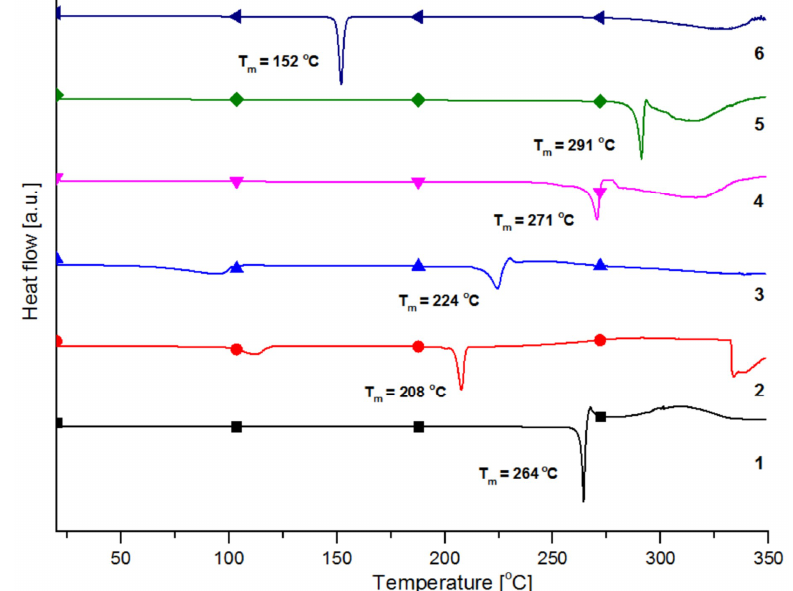
Figure 3. Combined graphical representation of the results from the DSC analyzes for compounds 1 – 6 with appropriate color and symbol scheme. The maxima of the endo effects, corresponding to the melting temperatures (T m ) for all compounds, are denoted.